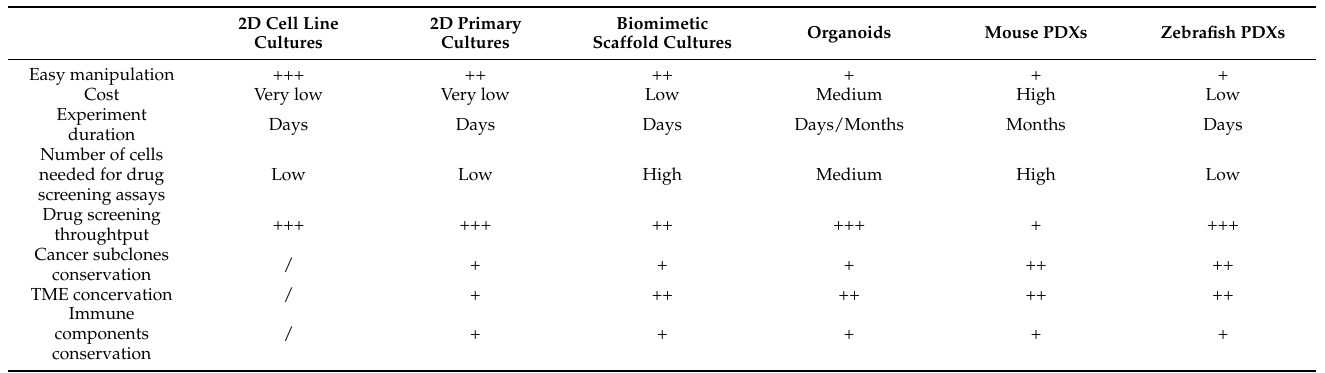
Table 1. Main characteristics of in vitro and in vivo preclinical cancer